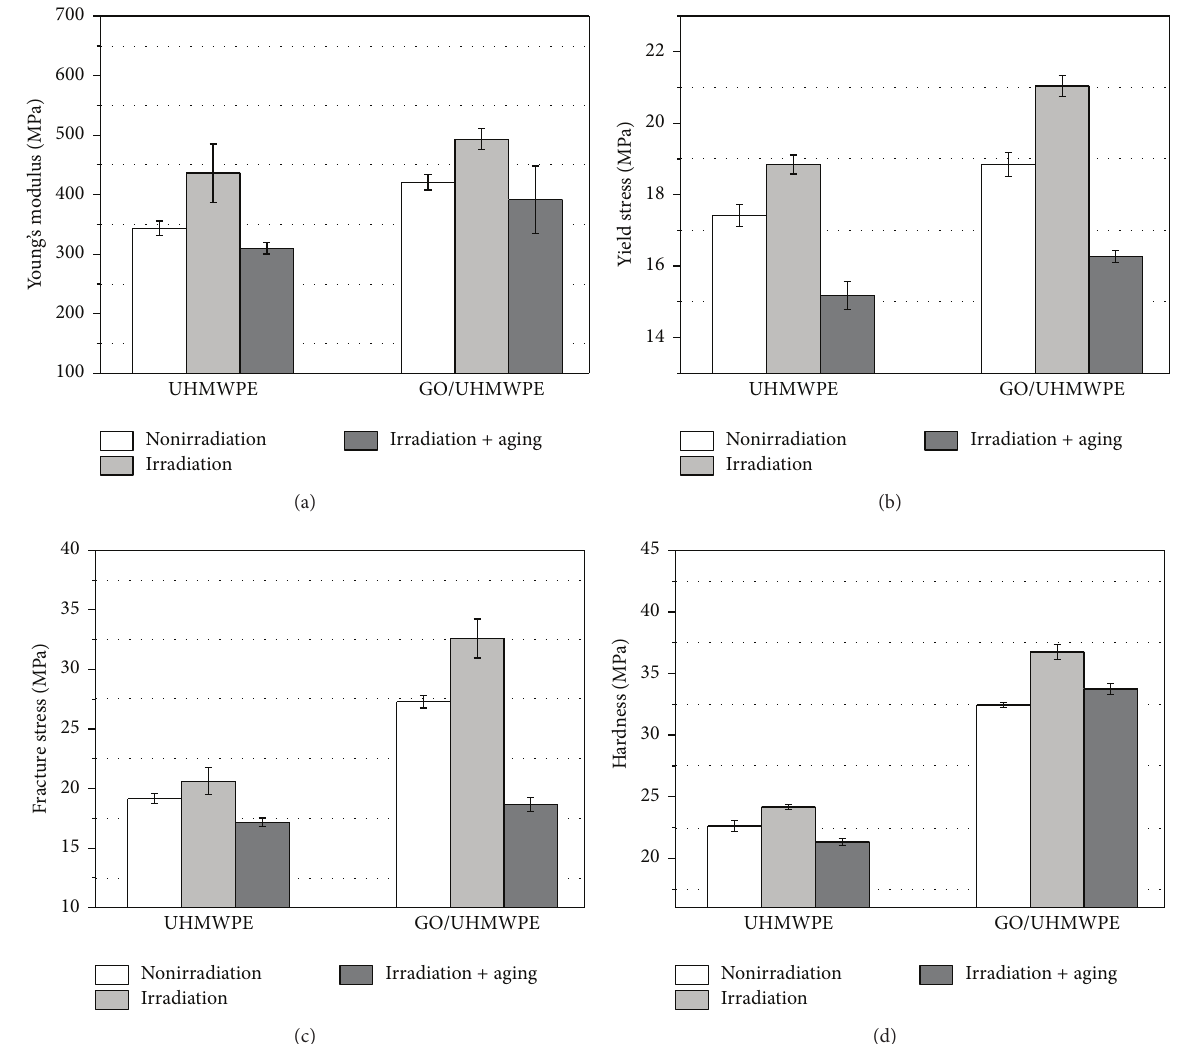
Figure 3: Mechanical properties: (a) Young’s modulus; (b) yield stress; (c) fracture stress; (d)